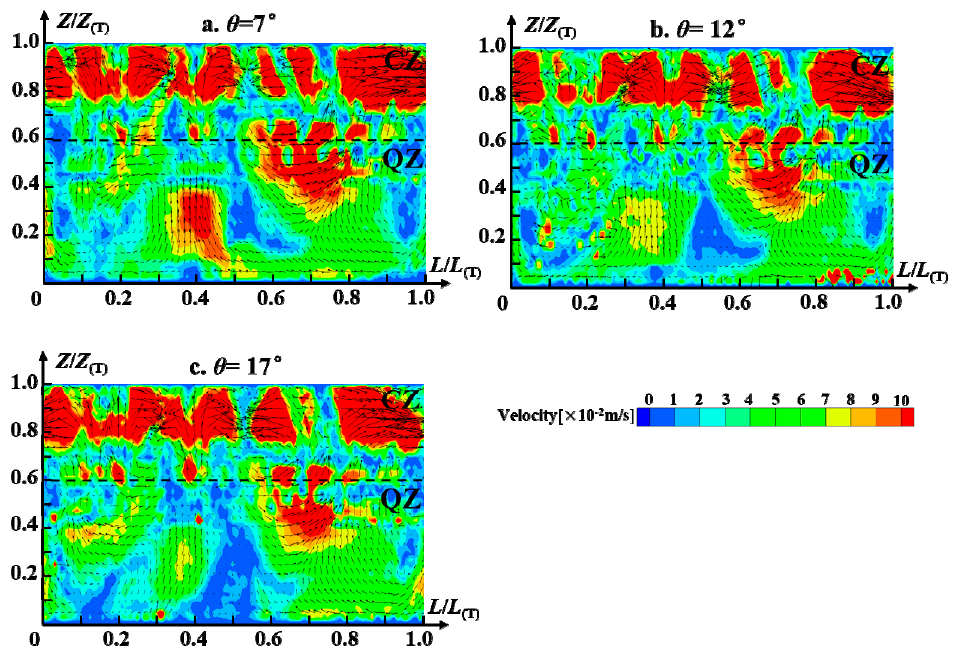
Figure 11. Flow patterns under di ff erent injection angles ( U = 44 m /